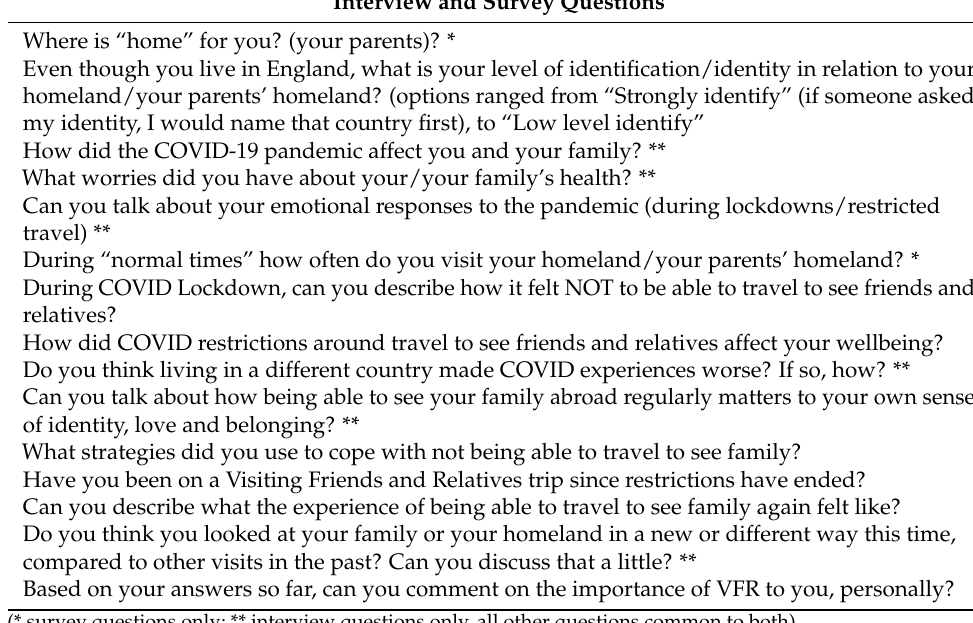
Table 1. Data Collection